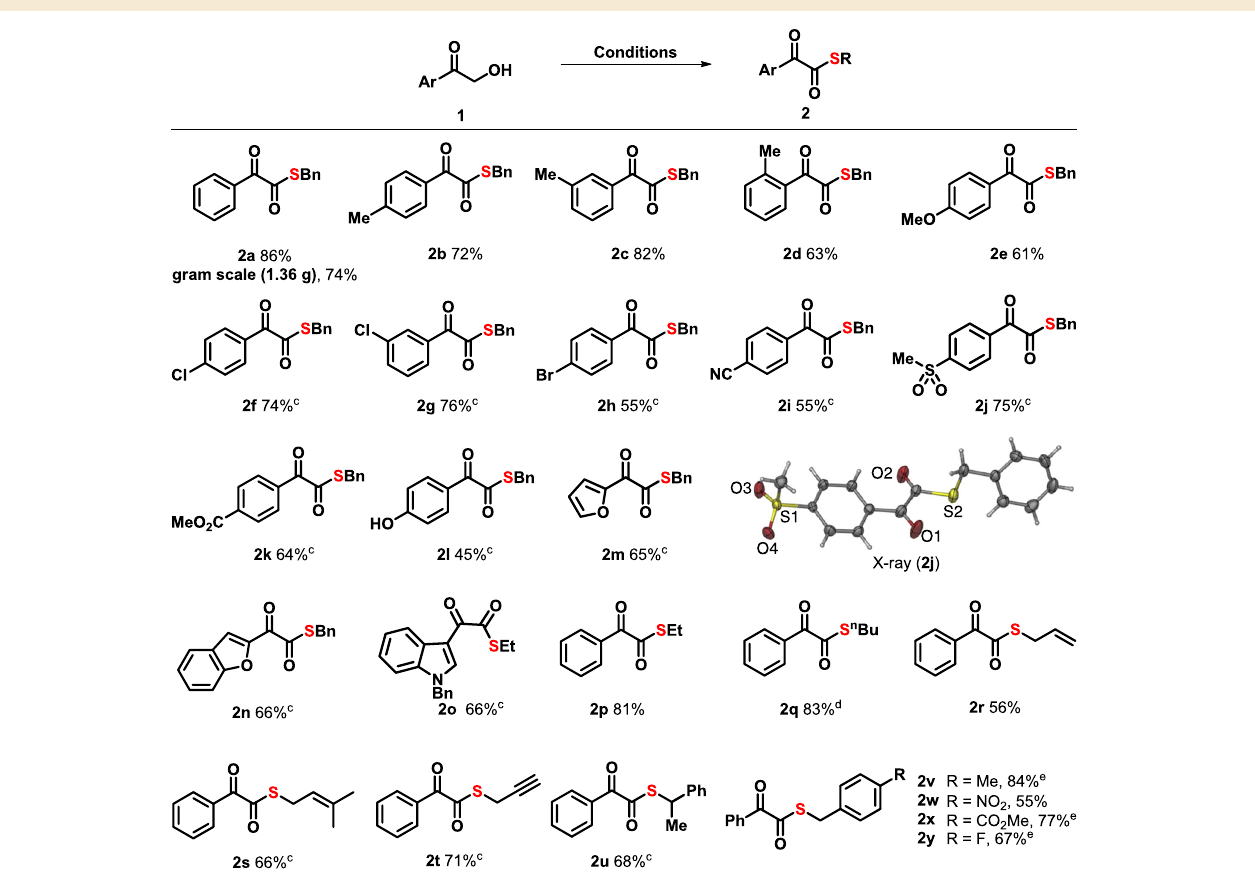
Table 2 Construction of a library of 1,2-dicarbonyl-forming reagents a,b